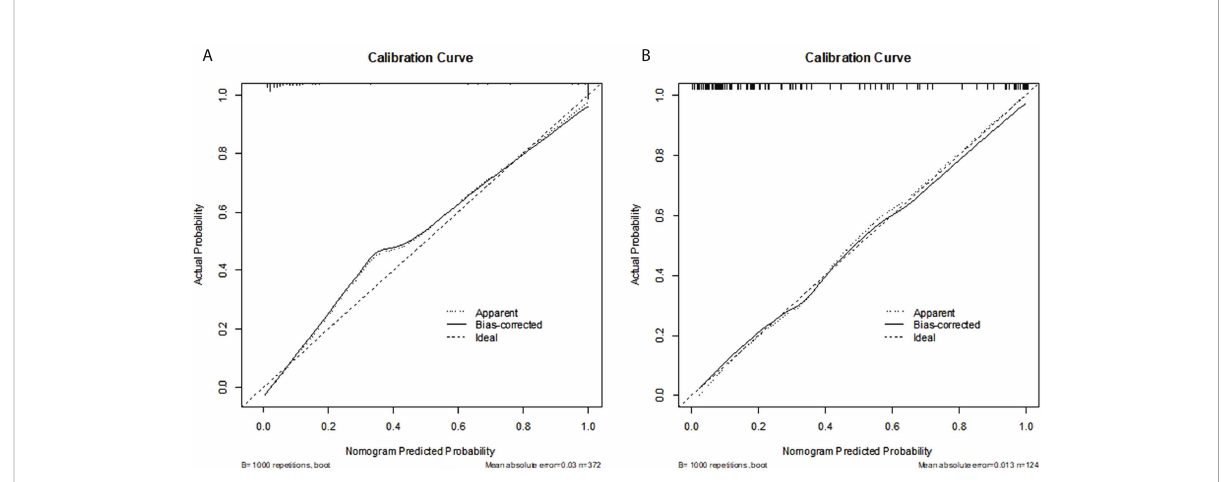
FIGURE 6 (A, B) Calibration curve of the nomogram for the development cohort and validation cohort. The X-axis represents the probability that nomogram predicted BC in BI-RADS US category 4 or 5 lesions, while Y-axis represents actual rate of it. The dotted line in the middle represents the perfect prediction, and the solid line represents the predictive power of the nomogram. The closer the solid line is to the dotted line, the better the predictive power of the model.